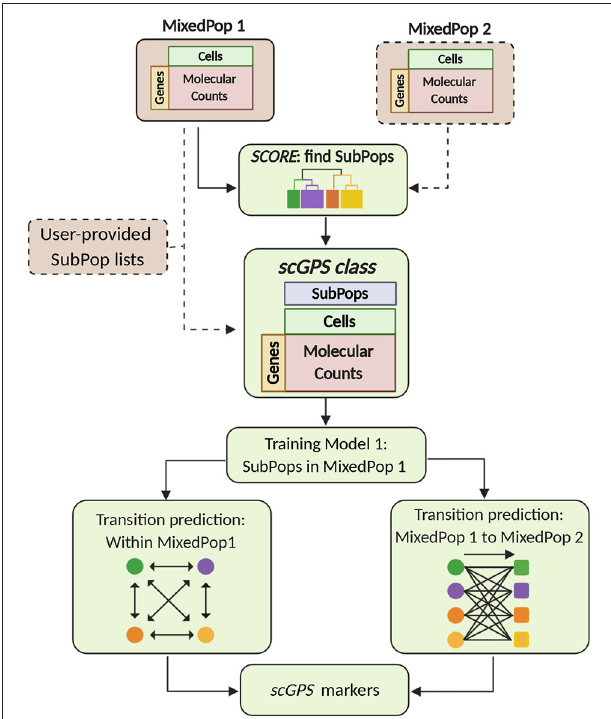
FIGURE 1 | scGPS workflow. Brown boxes represent inputs and green boxes show the main scGPS analysis. The dotted boxes represent optional inputs. The input for scGPS analysis can be either a single expression matrix or two expression matrices of two different cell populations, the following (shown as MixedPop 1 and MixedPop 2). scGPS provides the functionality to determine stable clusters within a cell population by SCORE algorithm. Alternatively, users can provide their predetermined subpopulation list (clusters). The scGPS class object is based on the widely adoptable SingleCellExperiment class ( Lun and Risso, 2019 ). Based on the subpopulation input, scGPS performs gene feature selection by training an Elastic net regularisation. Informative genes are then used in a logistic regression classifier to predict cell transition probability between subpopulations. When the input is one mixed sample (MixedPop1), scGPS computes the transition scores between different subpopulations within the same sample. When the inputs are two mixed samples (MixedPop1 and MixedPop2), scGPS computes the transition scores from the subpopulations in population one to those in population two. scGPS also predicts marker genes and their contribution to the transition between two subpopulations (refer to Supplementary Figure 1